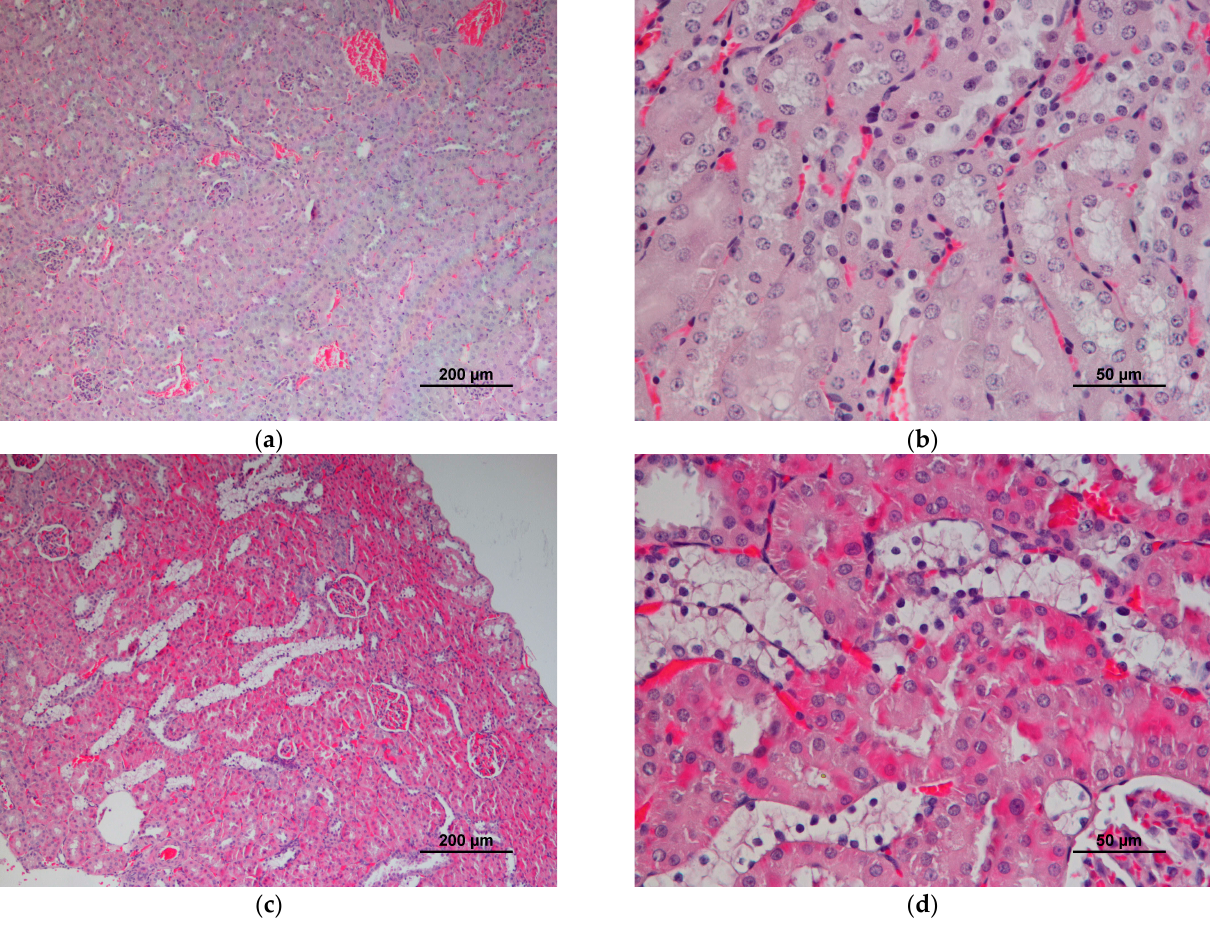
Figure 6. Kidney sections from the animals under study. Images ( a , b ) display normal glomeruli and cortical tubules from an animal of the control group. Notice the vacuolation of the cytoplasm and pyknosis of the epithelial cells of cortical tubules. Focal cell necrosis, marked by a darkly stained cytoplasm and sloughed necrotic cells in the lumen of cortical tubules, are also observed in images ( c , d ) from fructose-fed and STZ-injected animals. Table 3. Mean blood glucose levels per group after 12 h fasting and 2 h after feeding in both experimental groups at the 4th and 6th weeks of the